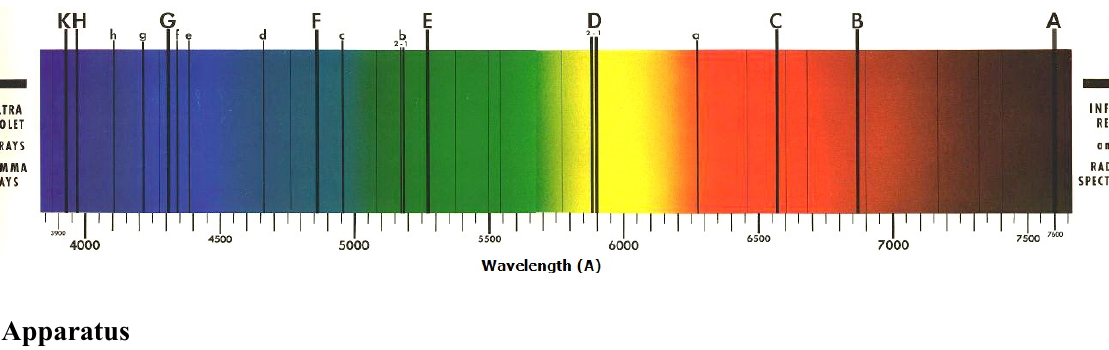
Figure 1. Fraunhofer lines for visible wavelengths